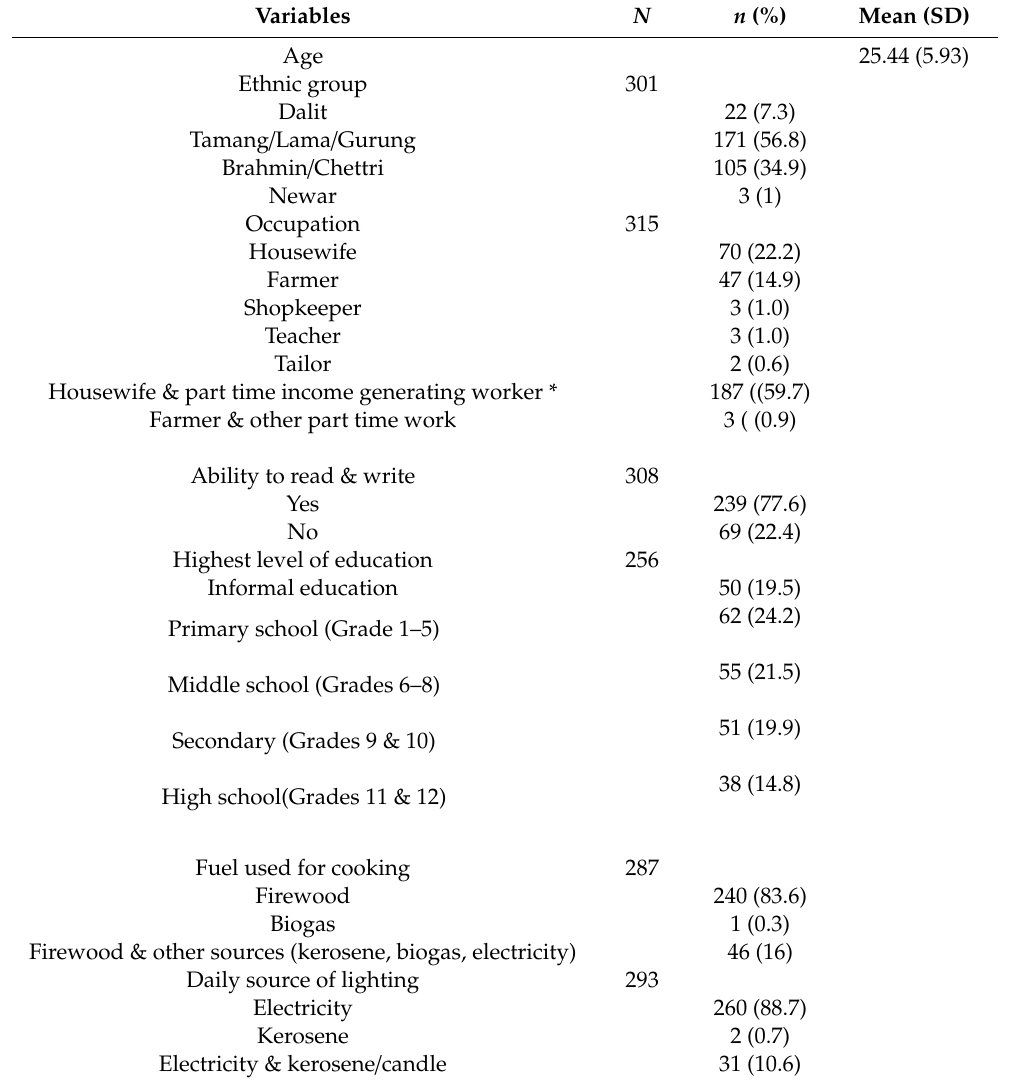
Table 1. Sociodemographic characteristics ( N =